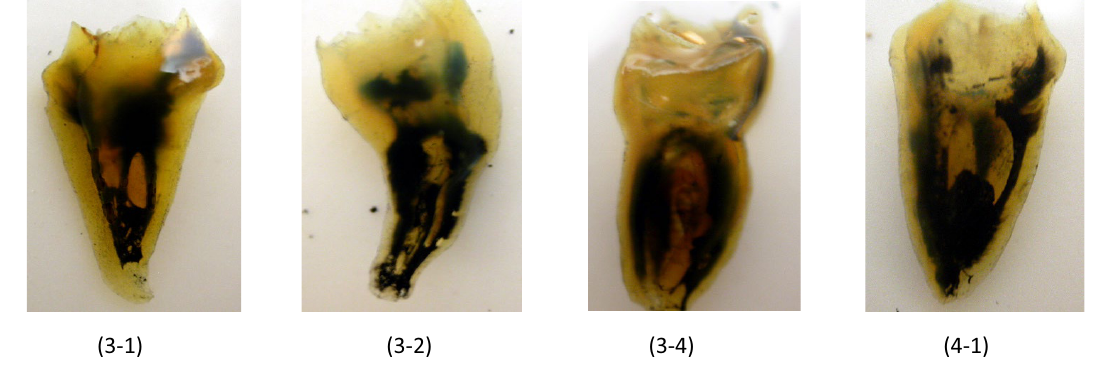
Figure 5. Cleared mandibular third molars with additional canal